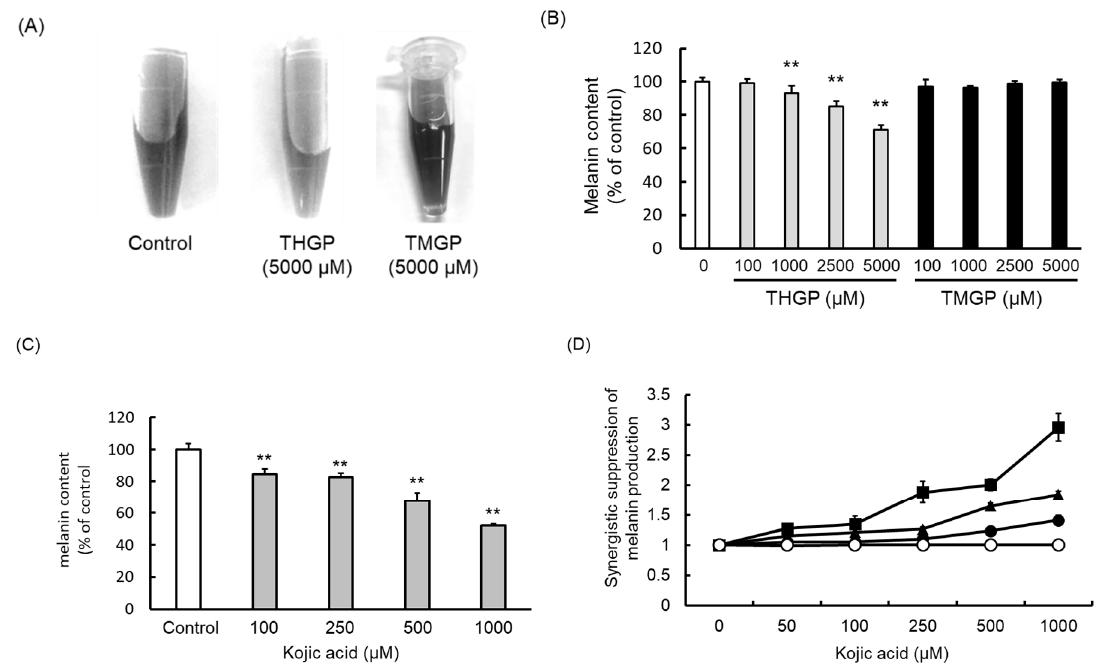
Figure 2. Inhibitory e ff ect of THGP, TMGP, and kojic acid on the synthesis of melanin via a reaction mediated by mushroom tyrosinase. ( A – C ) THGP, TMGP, or kojic acid was mixed with L-DOPA and mushroom-derived tyrosinase and allowed to react at 37 ◦ C for 20 min to synthesize melanin. ( D ) The suppressive e ff ect of the combination of THGP and kojic acid on melanin synthesis was examined. The results were statistically analyzed using Dunnett’s method, and 0 µ M THGP was used as the control. Circles: 0 µ M THGP; filled circles: 1000 µ M THGP; triangles: 2500 µ M THGP; squares: 5000 µ M